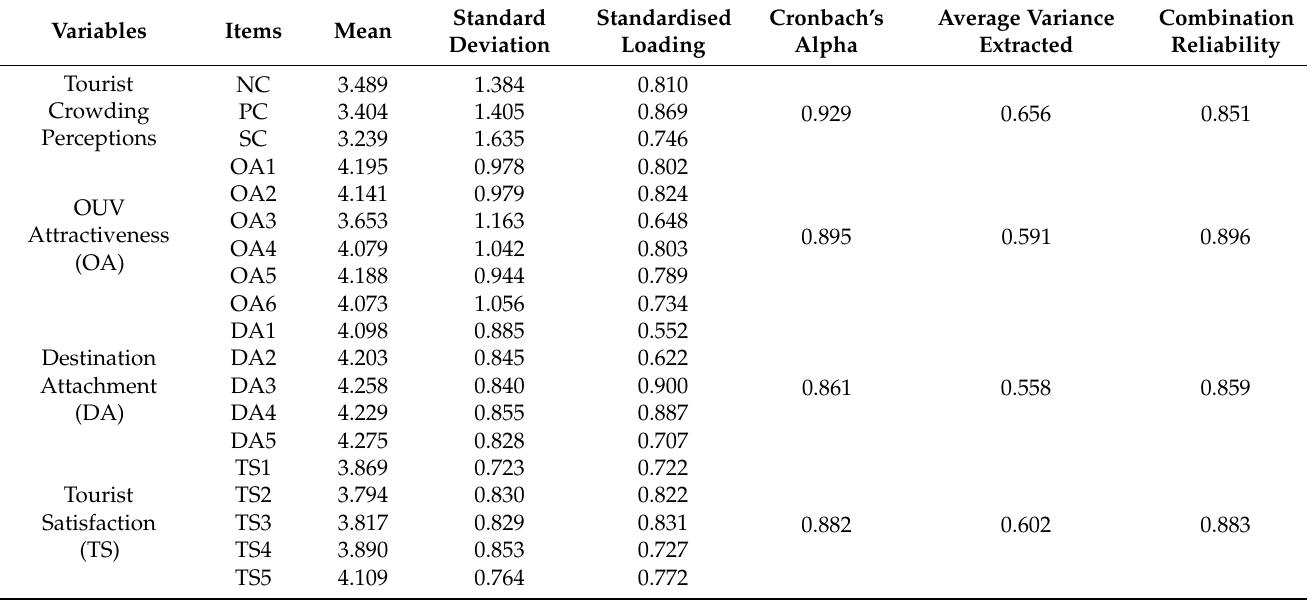
Table 4. Means, reliability, and convergent